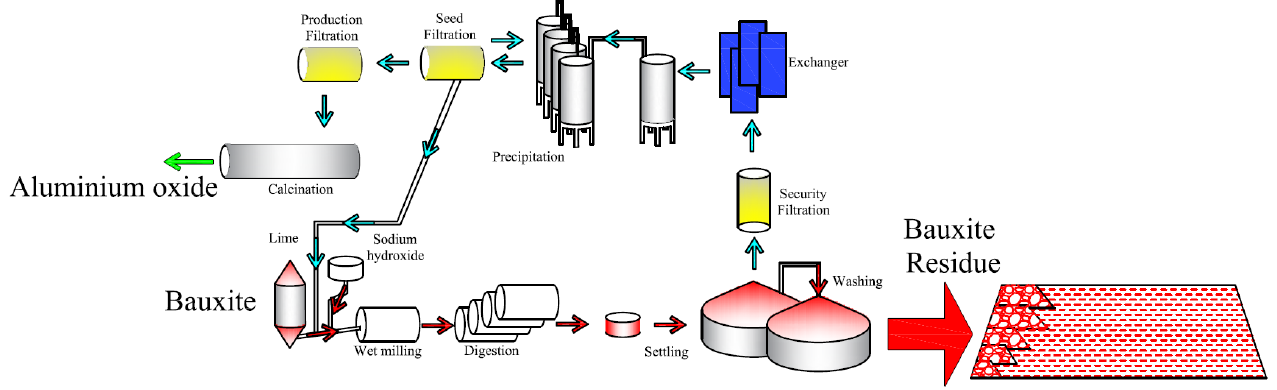
Figure 1. Generation of bauxite residue via Bayer process.